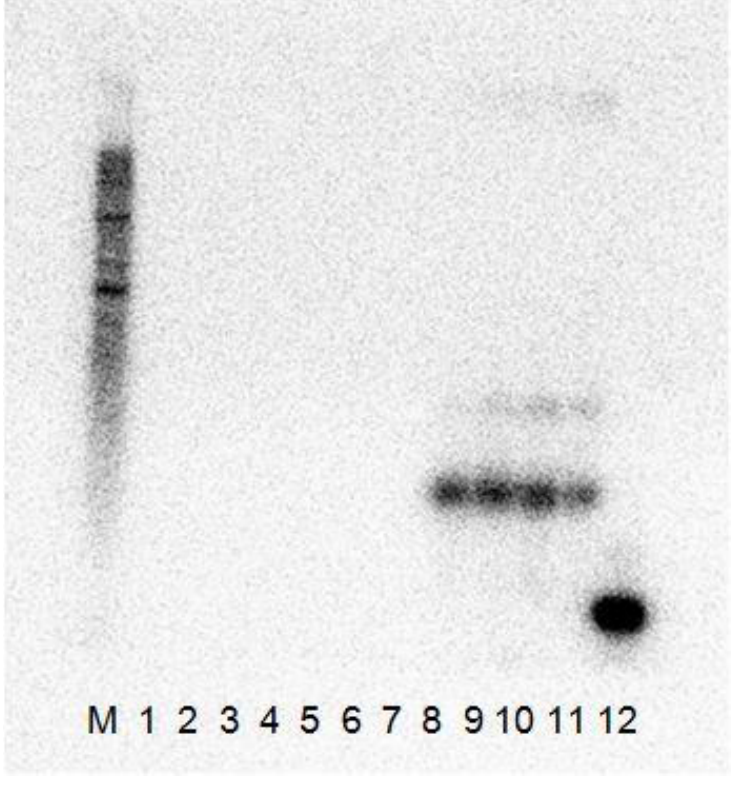
Figure 2. The Northern blot analysis results of the two L140-GFLV-satRNAfl clones 3 and 12 co-inoculated with ArMV-NW and GFLV-NW. Both constructs were shown to be infectious with only the GFLV-NW isolate as the helper virus and did not replicate with the ArMV-NW isolate as a helper virus. ( M ) RNA millennium (Ambion) marker, ( 1 ) ArMV-NW no satRNA control, ( 2 – 3 ) L140-GFLV-satRNAfl clone 3 co-inoculated with ArMV-NW, ( 4 – 5 ) L140-GFLV-satRNAfl clone 12 co-inoculated with ArMV-NW, ( 6 ) healthy C. quinoa control, ( 7 ) GFLV-NW no satRNA control, ( 8 – 9 )